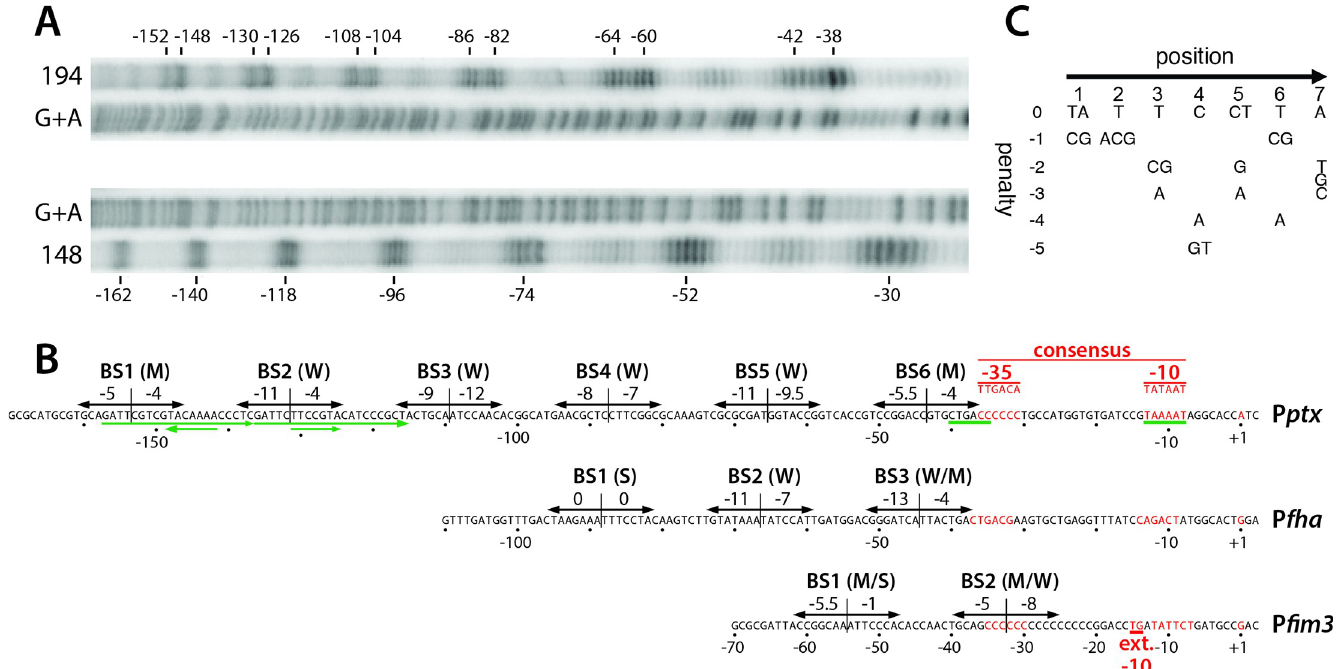
Fig 4. Details of BvgA-binding to the pertussis toxin promoter. A. BvgA Δ 127–129 derivatives in which both naturally occurring cysteine residues had been replaced by alanine and in which either the valine at position 148 or the threonine at position 194 had been replaced with cysteine, were subjected to derivatization with FeBABE and used to reveal the locations of BvgA-binding to the ptx promoter using methods previously described for a similar analysis of the fha promoter [12]. The protein modified at the 148 position produces cleavages at the outer boundaries of a bound dimer of BvgA~P, while the 194 derivative produces closely spaced cleavages corresponding to the location of the inter-monomer interface. Maxam and Gilbert A + G reactions of the same 32 P end-labelled P ptx DNA fragment were run in parallel for orientation. B. DNA sequences of the ptx promoter showing the sites of binding of BvgA~P derived from the analysis in panel A. In addition, each heptameric half-site has been scored according to the algorithm presented in panel C, with the scores given above the arrows indicating the binding half-sites. Nucleotides in red indicate core promoter elements, with the consensus sequence shown above. In a similar fashion, P fha and P fim3 are shown for comparison. Green arrows below the P ptx sequence indicate two 21 bp imperfect direct repeats and two inverted heptameric imperfect repeats previously cited as potential BvgA binding sites. C. Algorithm for predicting binding strength of BvgA-binding half-sites. This algorithm was derived from a study examining the ability of systematically mutated derivatives of the P fha primary binding site to bind BvgA~P and to activate transcription